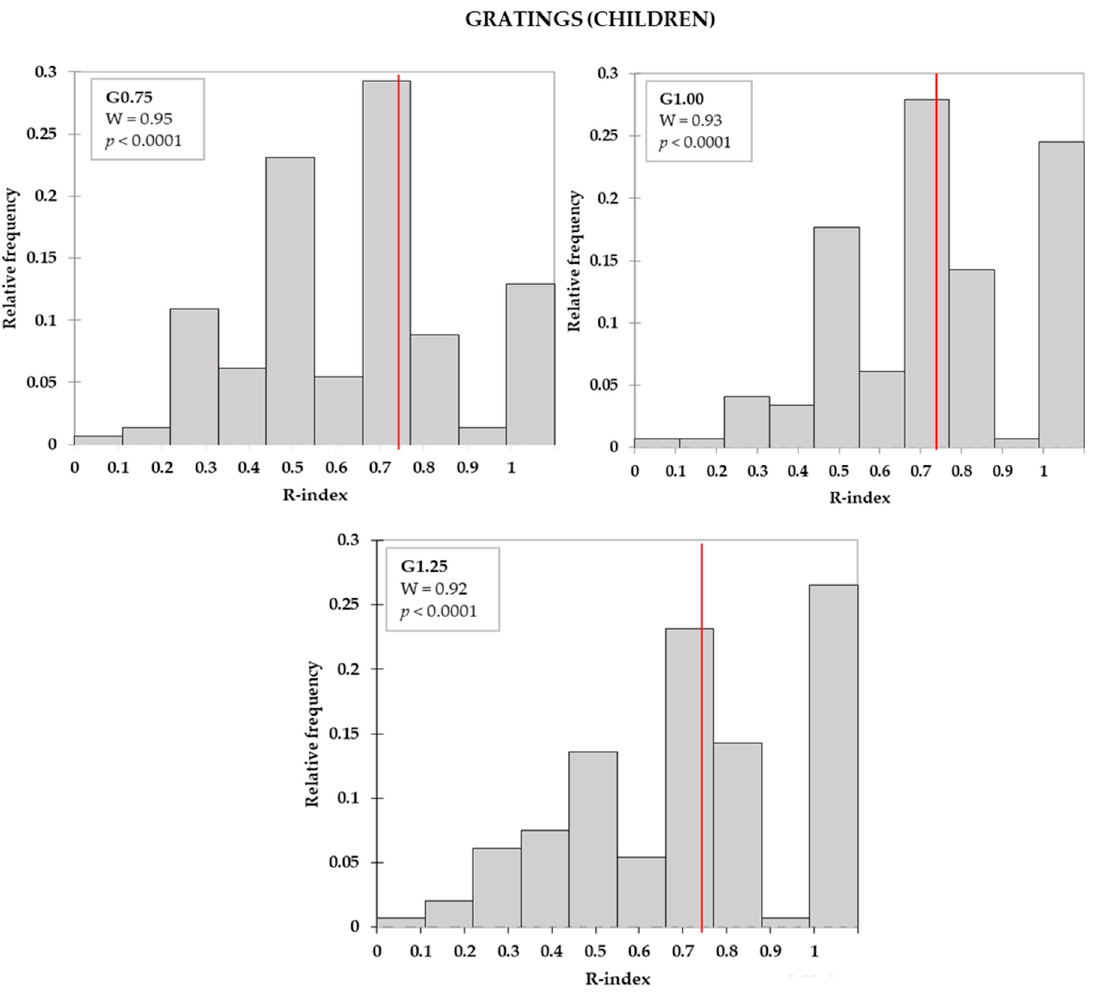
Figure 4. Children’s R-index distribution for gratings (G). The vertical lines indicate the R-index cut-o ff s for discrimination ( R = 0.74). The boxes show the Shapiro-Wilk test (W) statistics and respective levels of significance.